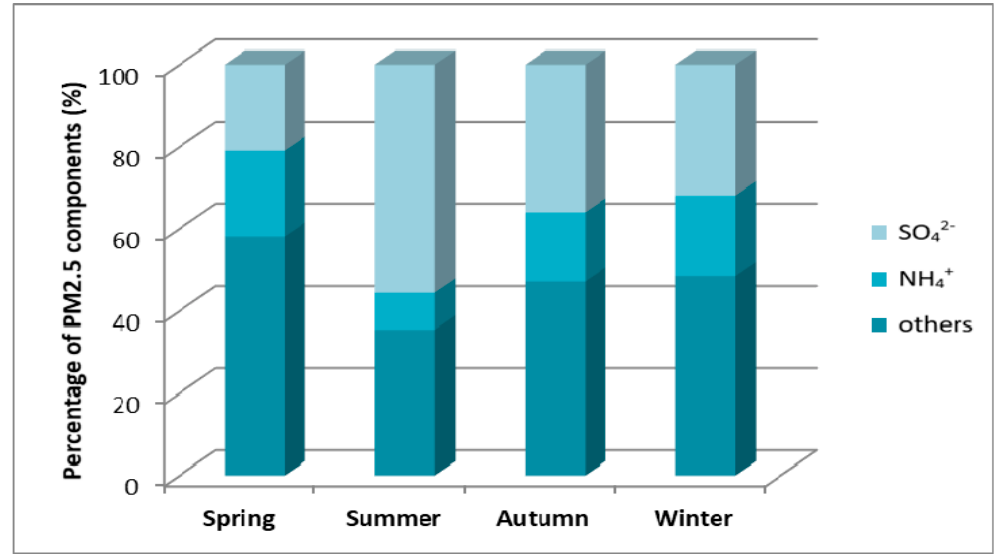
Figure 15. Mass percentage of PM2.5 components in particular seasons of 2010 in the monitoring station in Katowice [23].